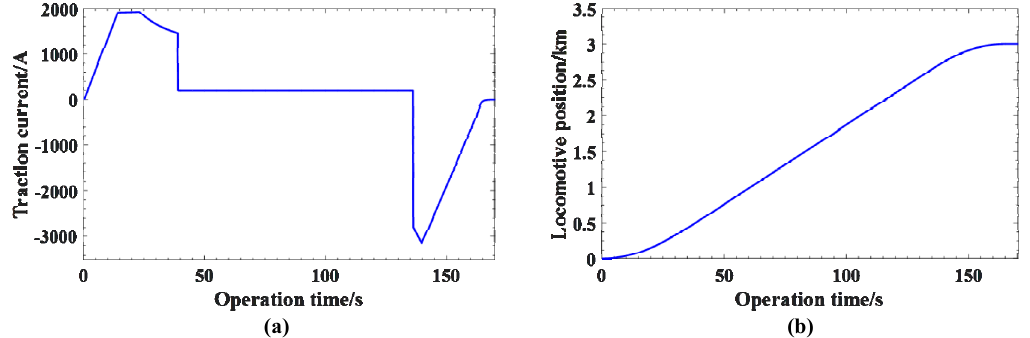
Figure 10. Locomotive dynamic characteristics: ( a ) Traction current; ( b ) Locomotive position.